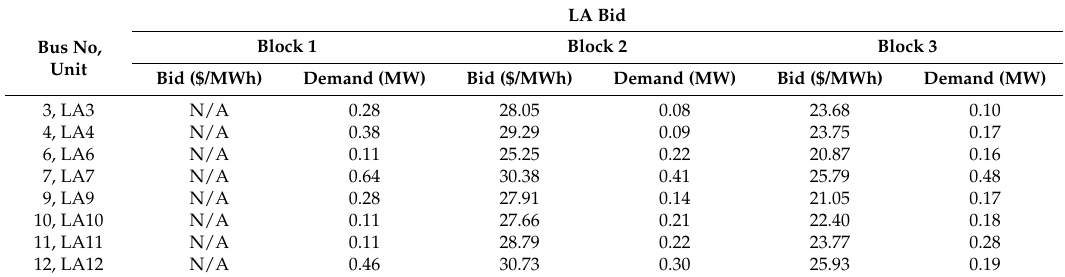
= 30%) for each block at 2:00 p.m. i